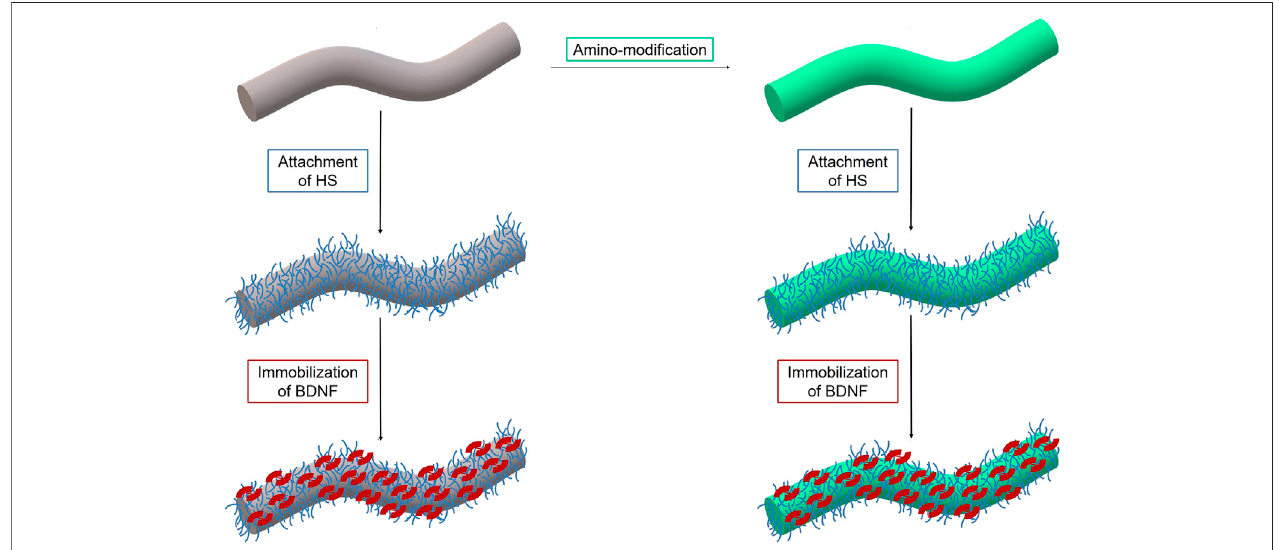
FIGURE1| SchemeofsurfacefunctionalizationofPGA/PCLpolymer fi ber(grey)includingamino-modi fi cation(green)ofthesurfaceandsubsequentattachmentof heparan sulfate (blue) and loading of the growth factor BDNF (red).